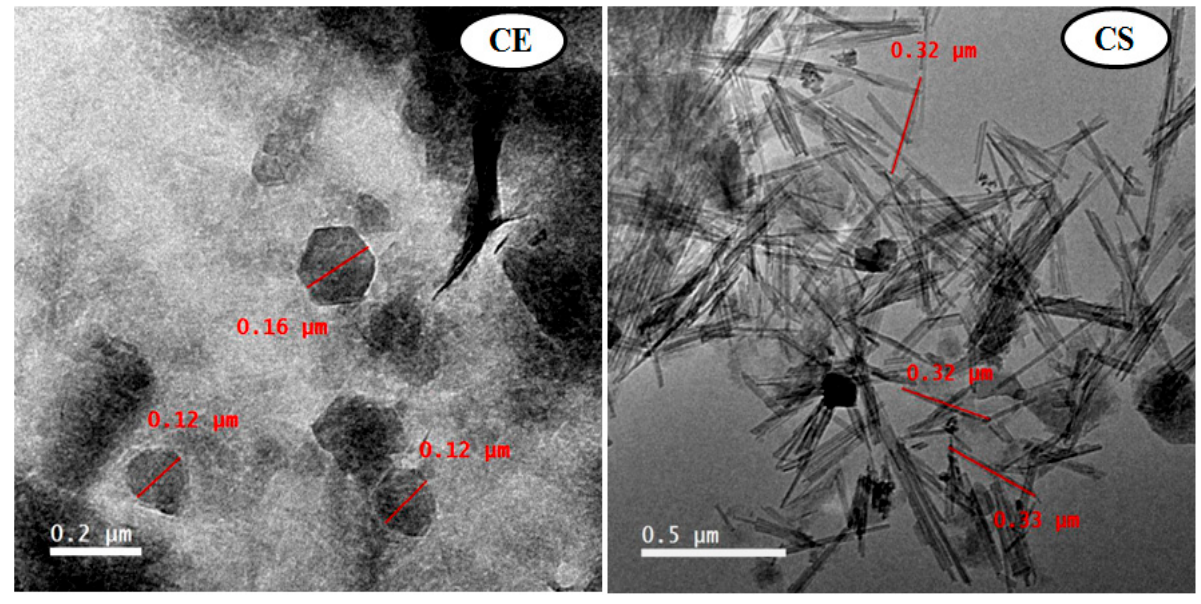
Figure 2. TEM images of Egyptian nanoclay (CE) at 0.2 μ m and standard nanoclay (CS) at 0.5 μ m .